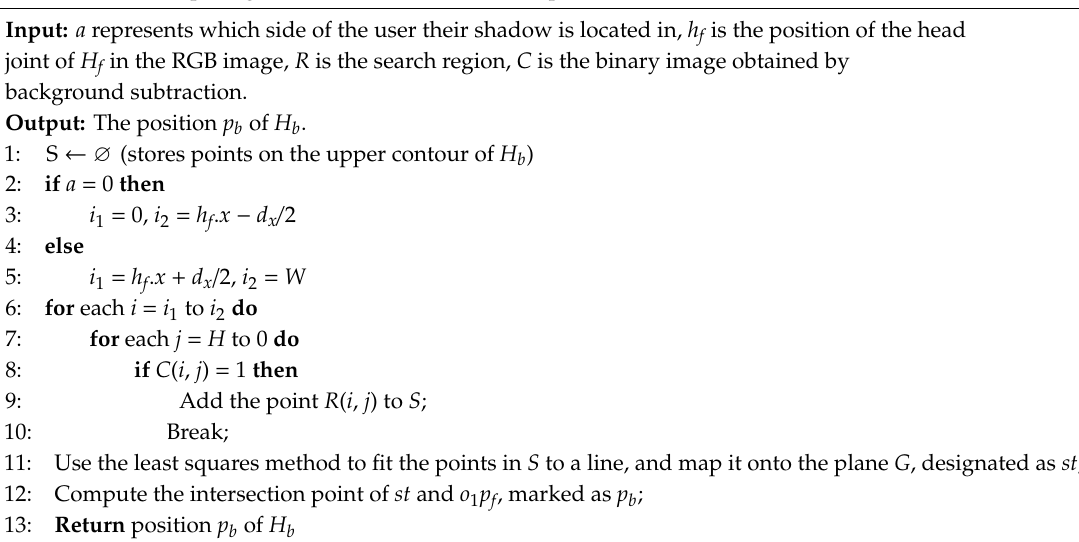
Algorithm 2. Computing the Position of Occluded People via